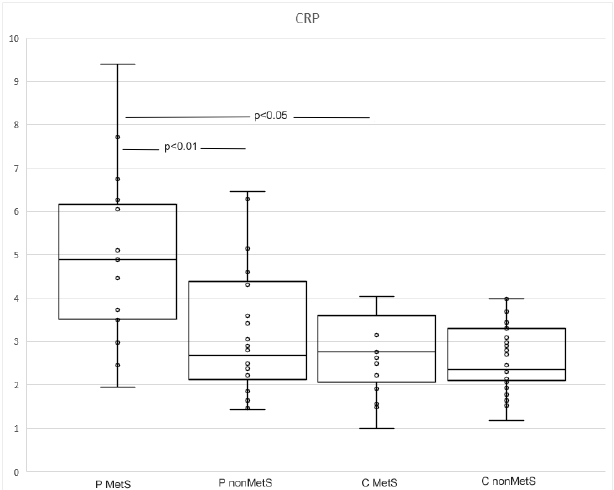
Table 3. PASI score of all patients.